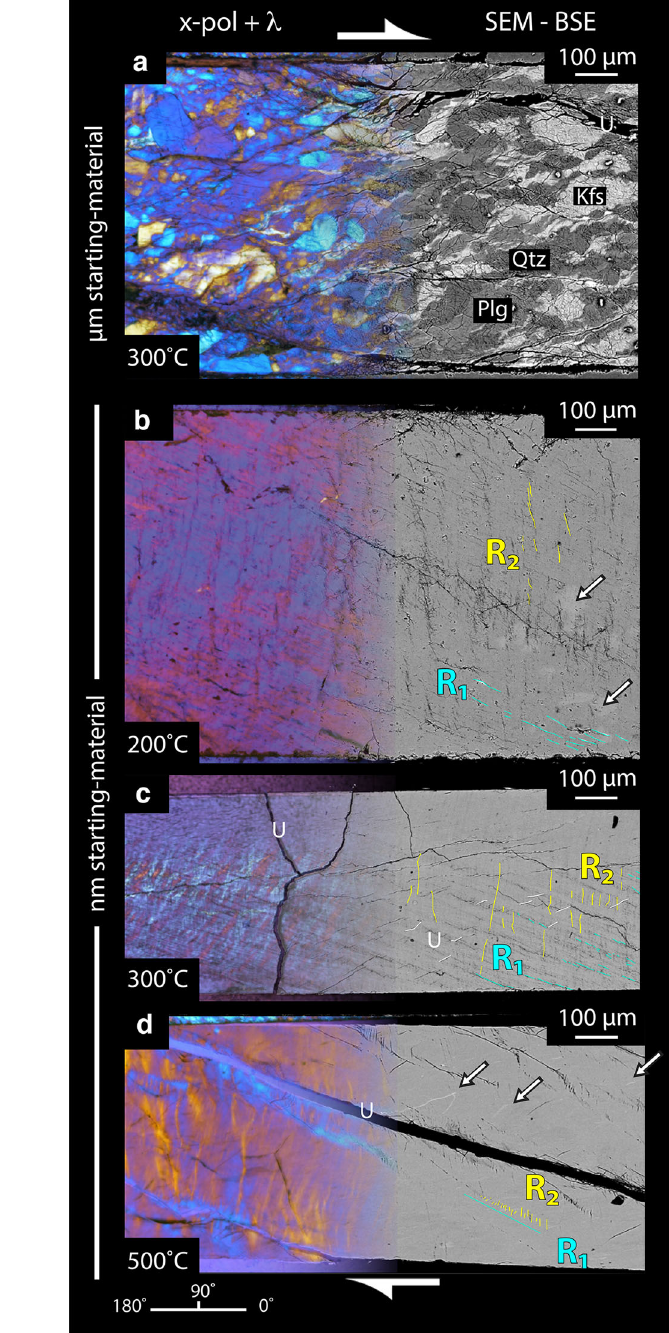
Fig. 2 Microstructural observations of the sheared fault rocks in polarized light (left) and SEM-BSE (right). Kfs - potassium feldspar, Qtz - quartz, Plg - plagioclase, U - unloading cracks. R 1 & R 2 - Riedel shears. Angle convention shown in the lower left. a Microcrystalline fault rocks. b Nanocrystalline fault rocks deformed at 200 °C. Note pervasive R 1 and R 2 fractures and locally brighter material in BSE z-contrast indicating different chemical composition and/or density (arrows) c Nanocrystalline fault rocks deformed at 300°C, note alternating cyan/orange layers highlighting kink- bands in the optical image. d Nanocrystalline fault rocks deformed at 500°C. Arrows indicate stretched layers and smeared out domains indicative of continuous fl